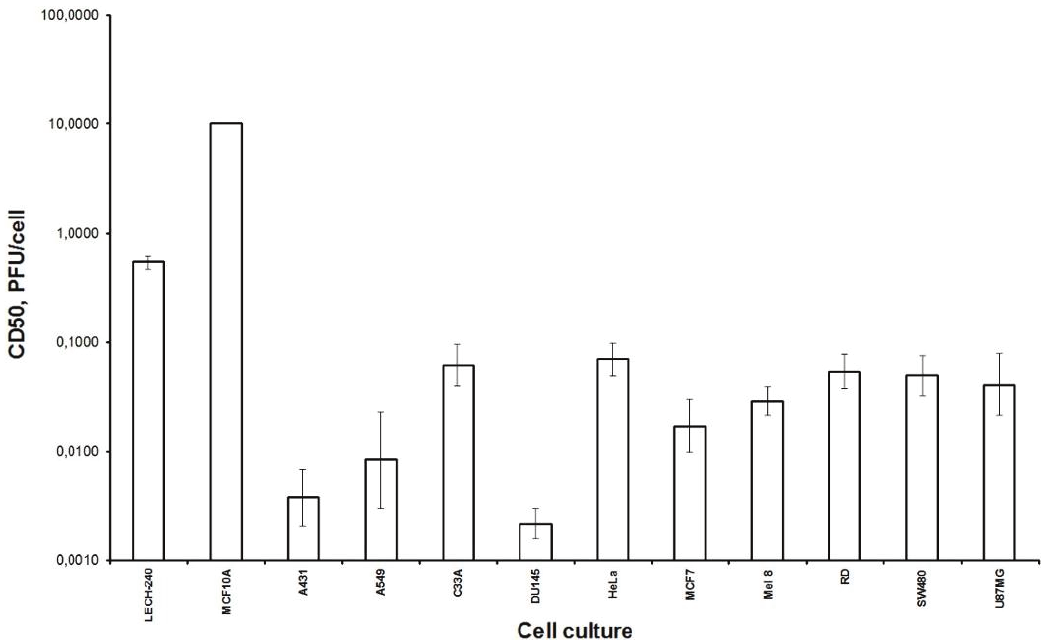
Figure 1. Cytotoxic activity of vaccinia virus (VACV) strain L-IVP in human cells. Ten tumor cell lines were used: A549, A431, C33A, U87MG, RD, DU145, MCF7, Mel8, SW480 and HeLa. Diploid human embryonic LECH-240 and normal breast epithelium MCF10A cells were tested to make a comparison. Cells were grown in 96-well plates, infected with virus doses ranging from 0.001 to 10.0 PFU/cell (sequential tenfold dilutions); 50% cytotoxic dose (CD 50 ) was calculated using the XTT test (see Materials and methods). Statistical analysis included results of three independent experiments. Data are presented as the mean ± SD.